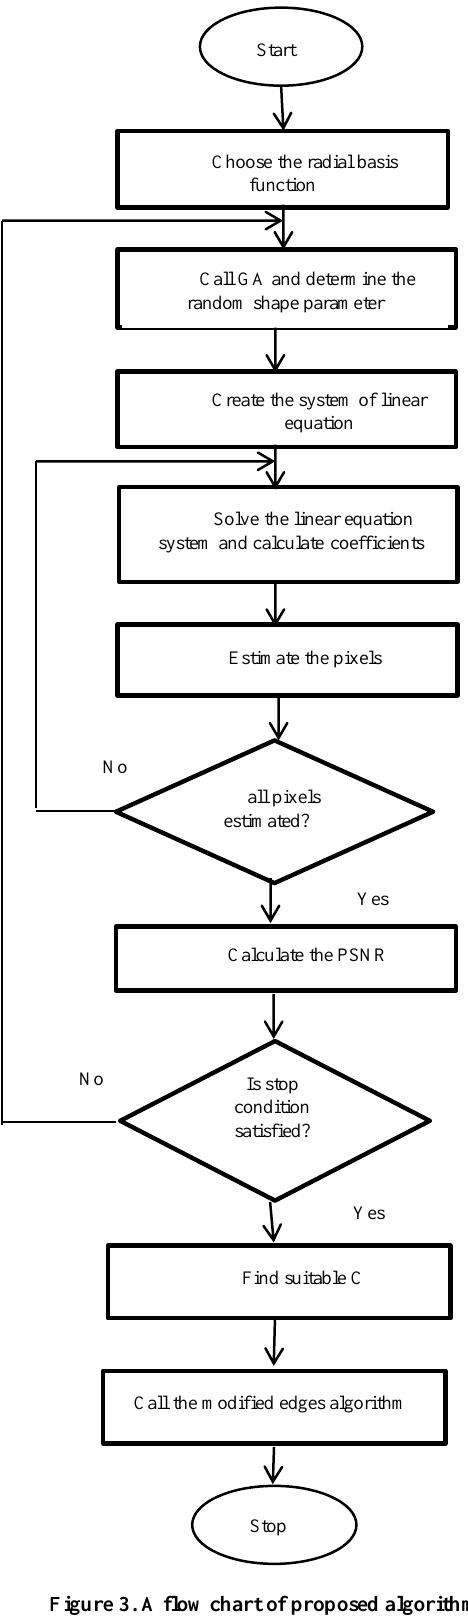
Figure 3. A flow chart of proposed algorithm.